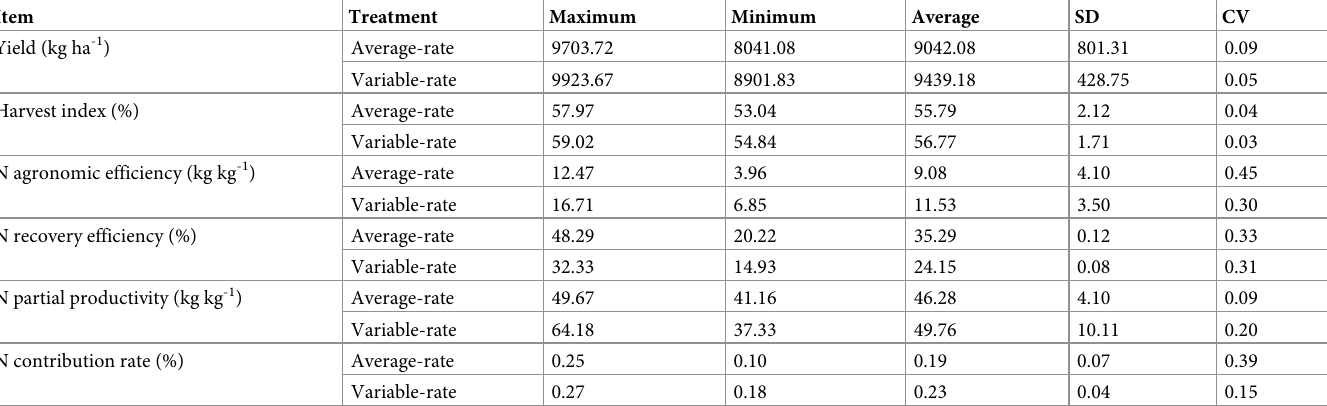
Table 4. Yield, harvest index and N use efficiency under the leaf value model based on the variable rate fertilization in